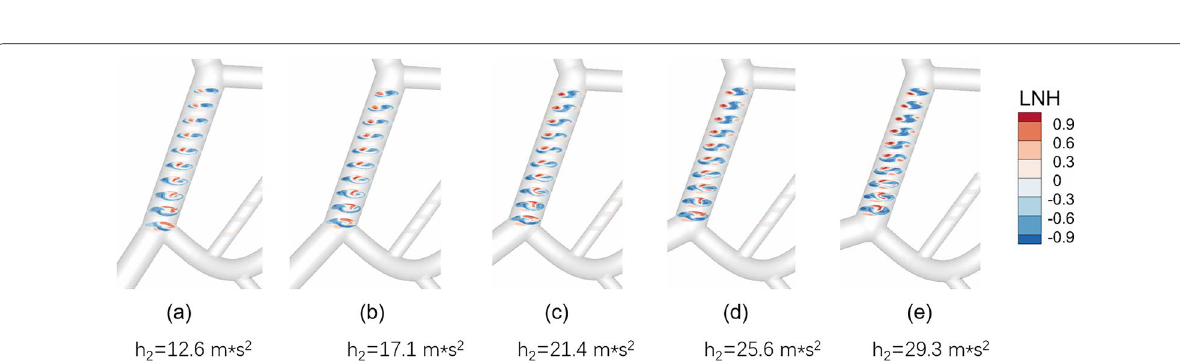
80°, 90°, 100°, 110°, 120°, respectively; b and c show the flow = 80° and the model with α 120° = =